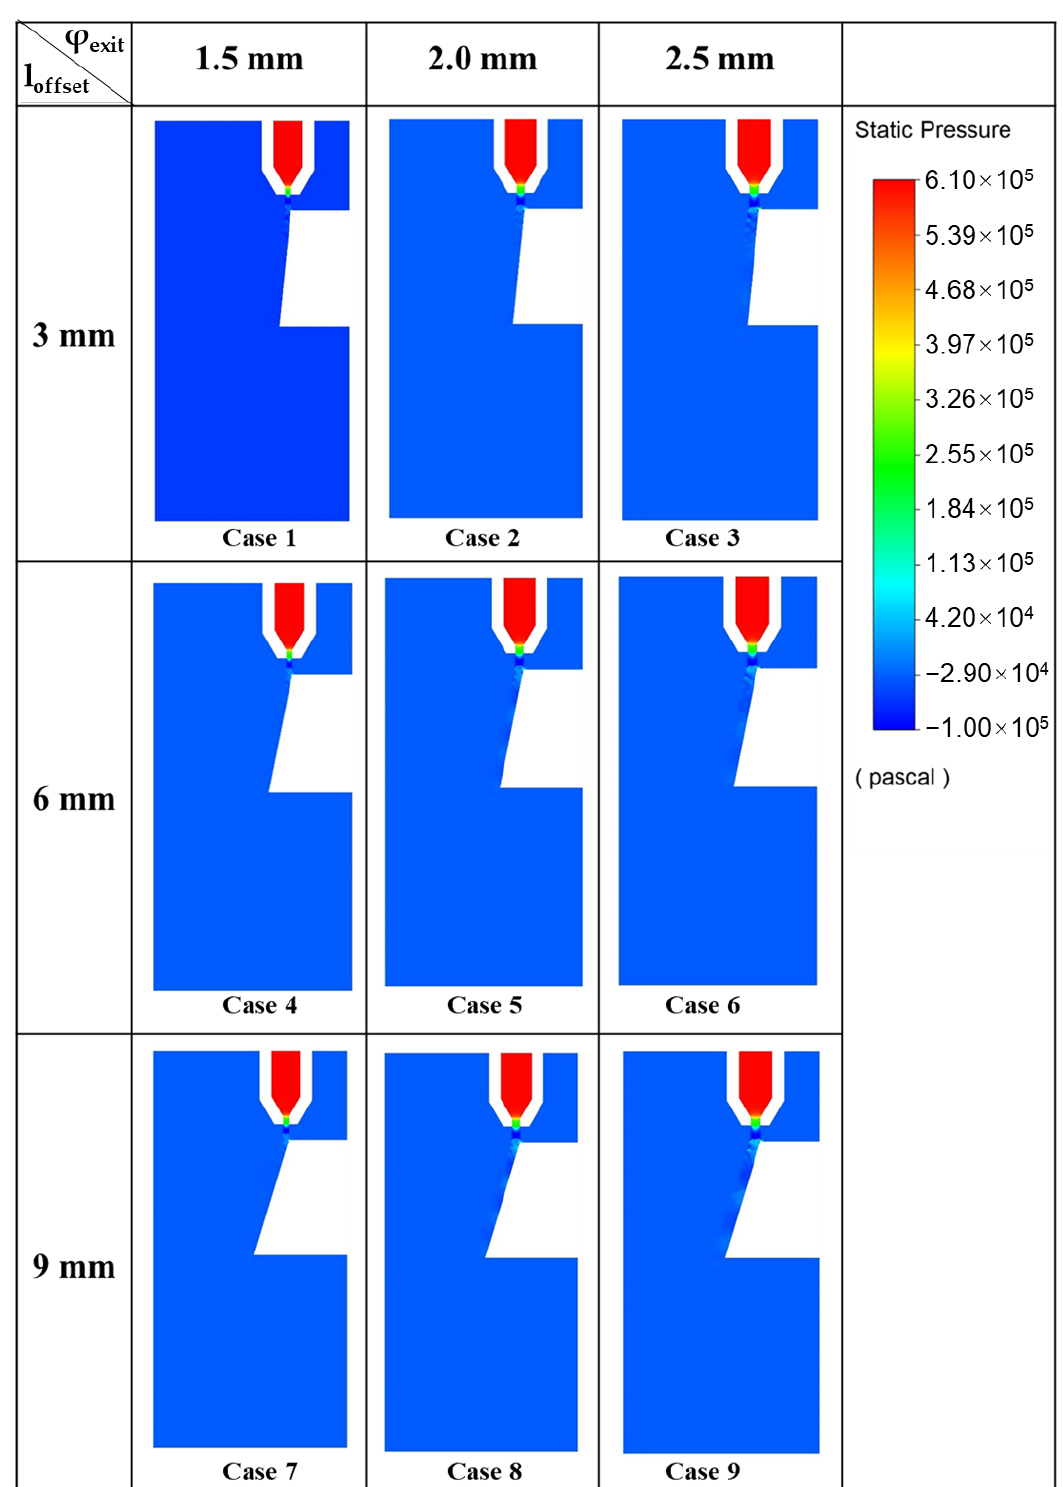
Figure 9. Numerical simulation results for the pressure field along the symmetry plane.